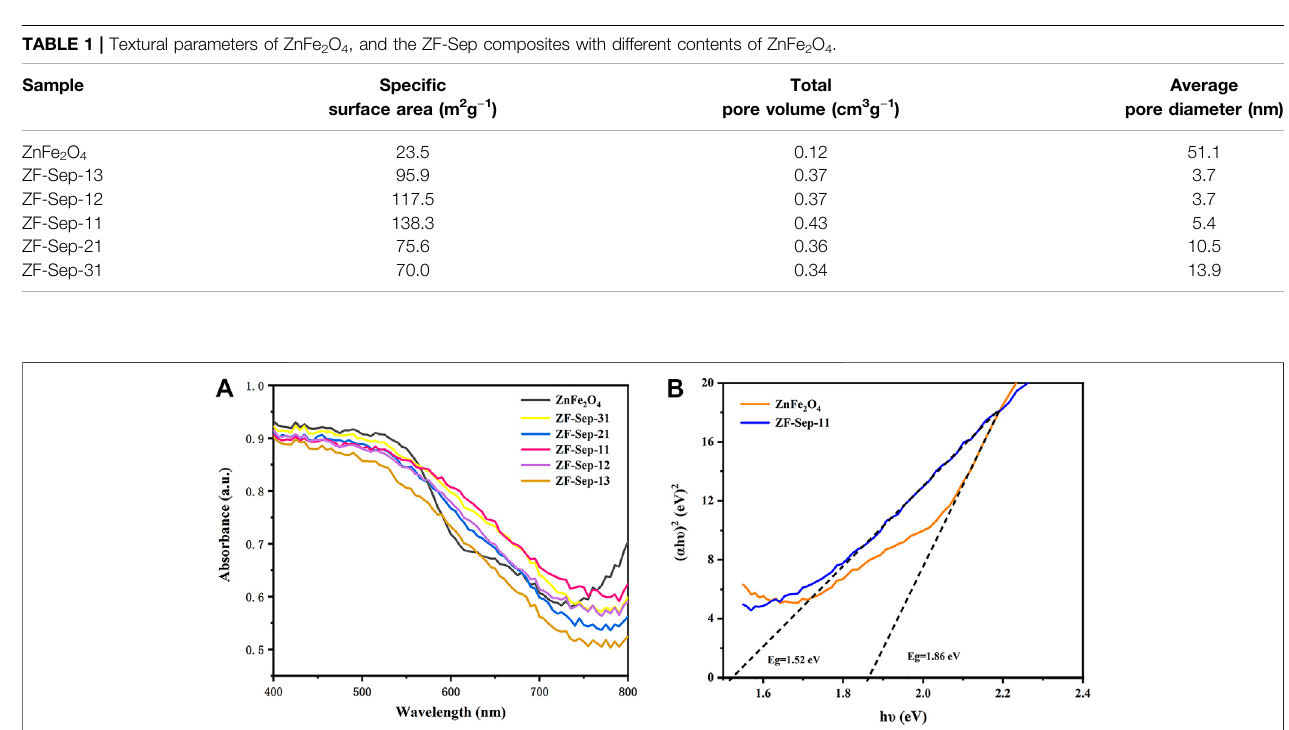
FIGURE 7 | (A) UV-vis spectra of ZnFe 2 O 4 and ZF-Sep composites (B) Plots of ( α h ν ) 2 vs h ν of ZnFe 2 O 4 and ZF-Sep-11.